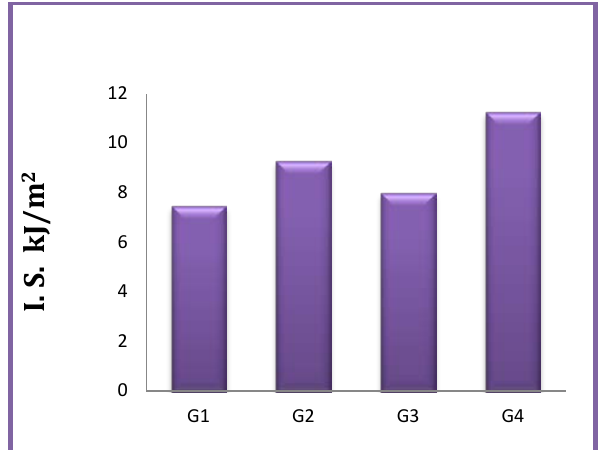
Fig.4: Impact strength for PMMA reinforced with coated and uncoated chopped C.F.